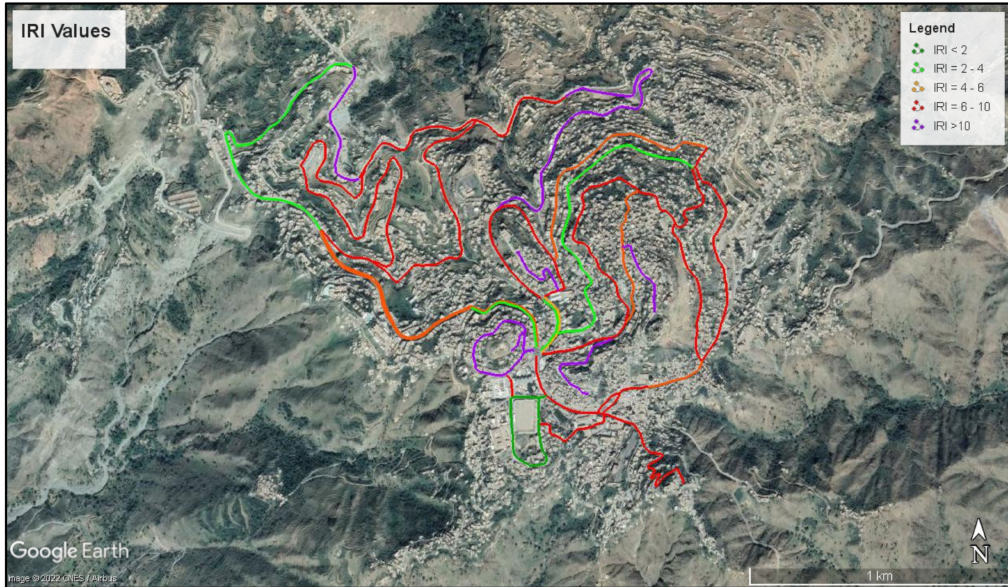
Figure 8. The IRI values in a color-coded Google Earth